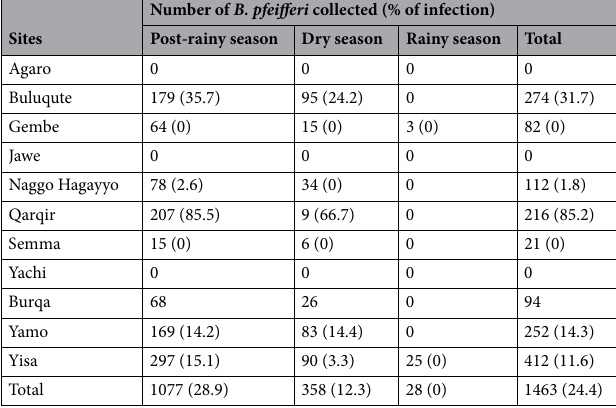
Table 2. The proportion of infected B. pfeifferi by collection sites and